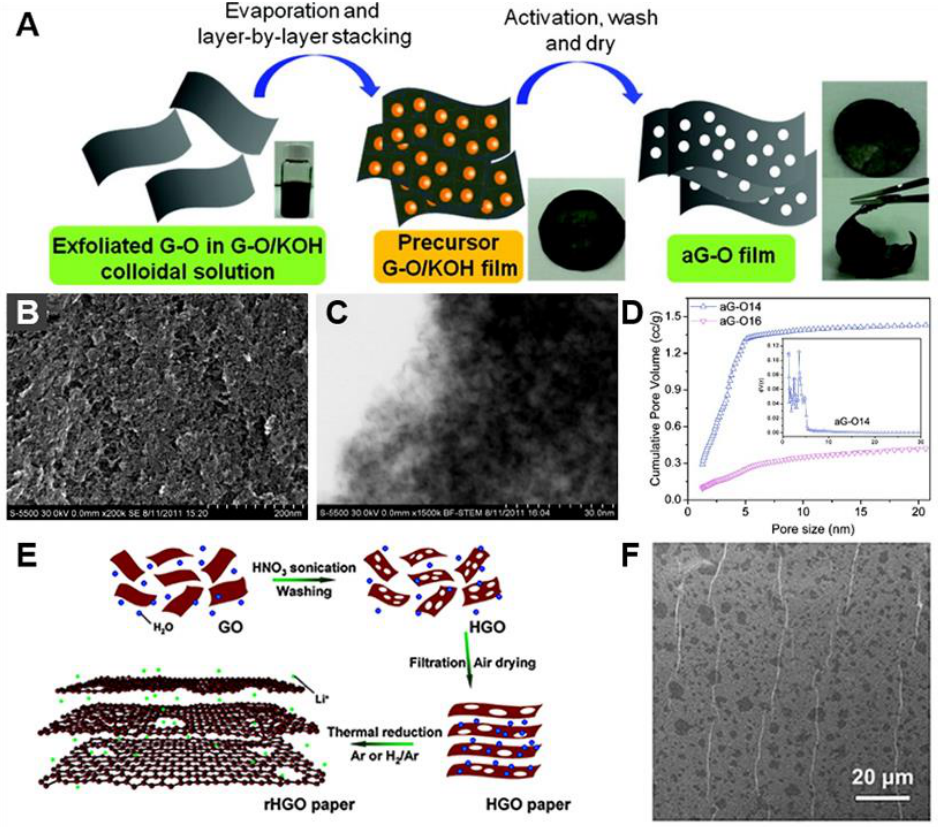
Figure 6. ( A ) Scheme of the preparation of microwave exfoliation of GO (MEGO) and the following activation process with KOH to generate nanopores. ( B ) High-resolution scanning electron microscopy (SEM) image, ( C ) Gas (N 2 , Ar, and CO 2 ) physisorption isotherm of an a-MEGO, and ( D ) cumulative pore volume and pore size distribution (inset). ( A – D ) Reprinted with permission from Ref. [102], Copyright (2012) American Chemical Society. ( E ) Scheme of the formation of in-plane pores into GO by HNO 3 etching and ( F ) SEM image of holey GO sheets. ( E , F ) Reprinted with permission from Ref. [103], Copyright (2011) American Chemical